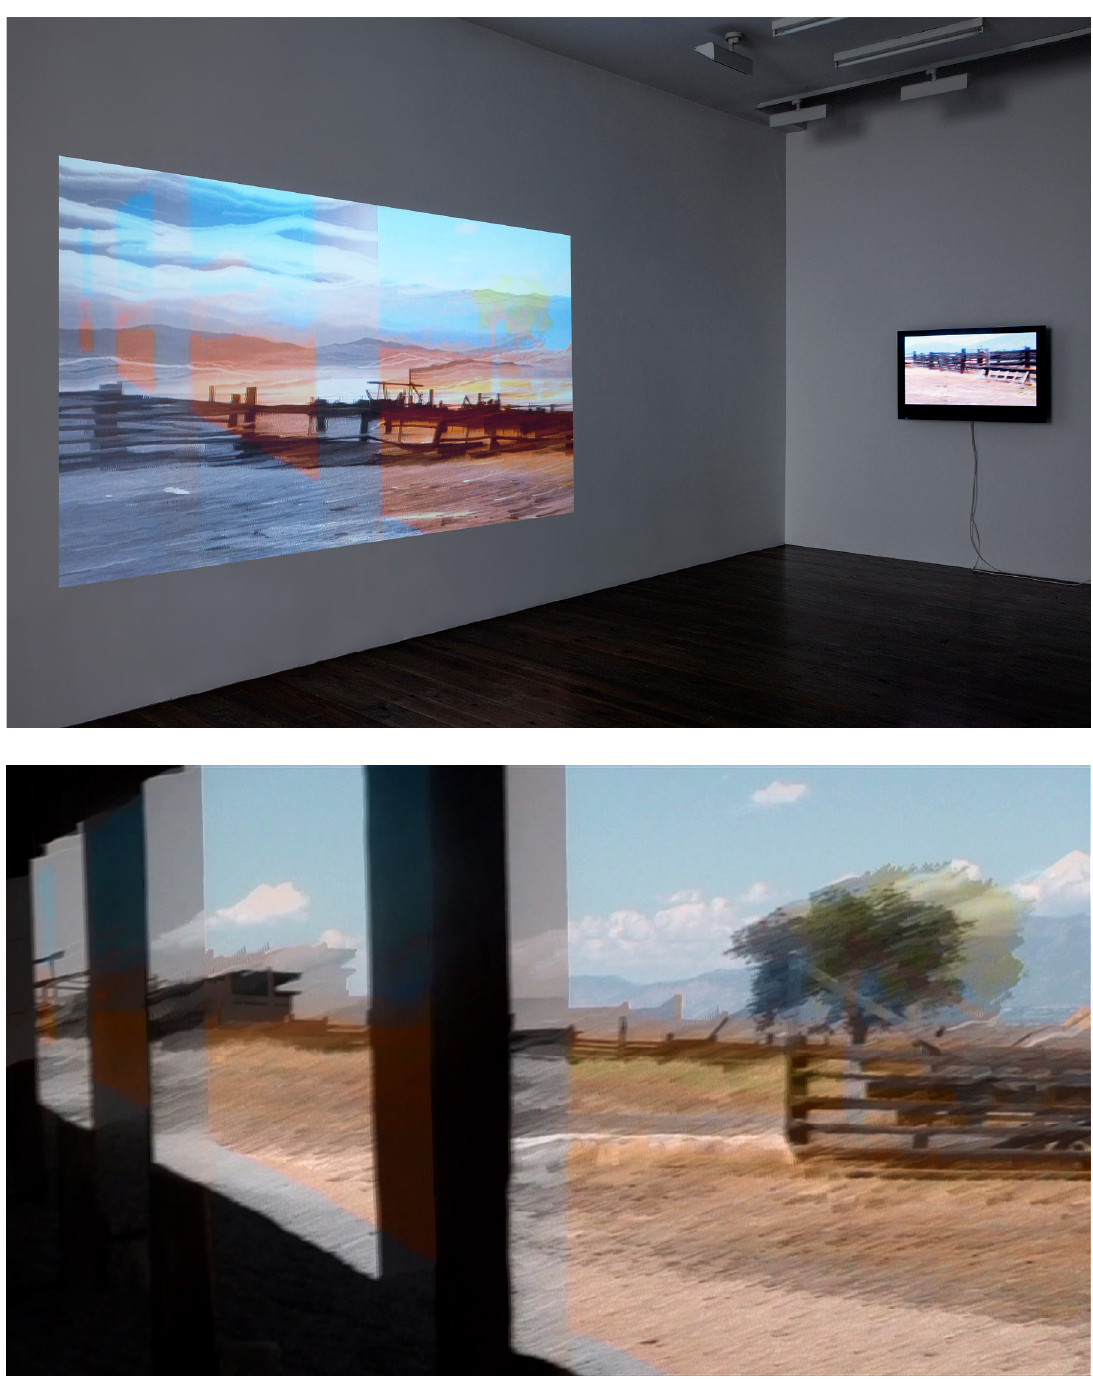
Figs 3 and 4 Roos Theuws, Fences & Pools, 2012, 2-channel video